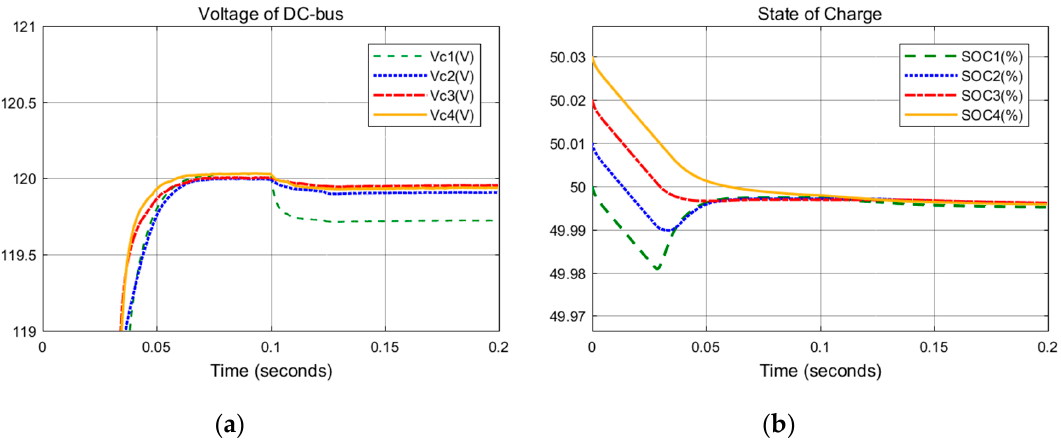
Figure 11. Distributed cooperative control when failure at 0.1 s of DCES1: ( a ) DC-bus voltage; ( b ) battery SOC.